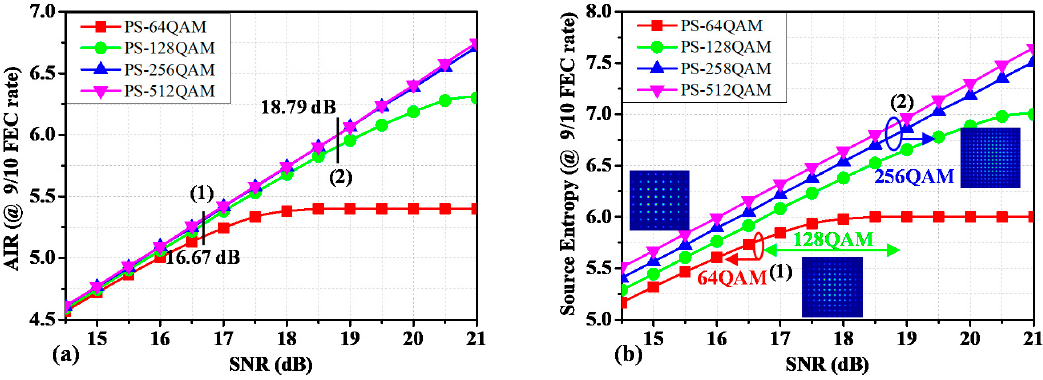
Figure 3. Achievable information rate (AIR), SE and generalized mutual information (GMI) performance at 0.92 NGMI threshold. ( a ) AIR performance at 0.92 NGMI threshold; ( b ) SE performance at 0.92 NGMI threshold.